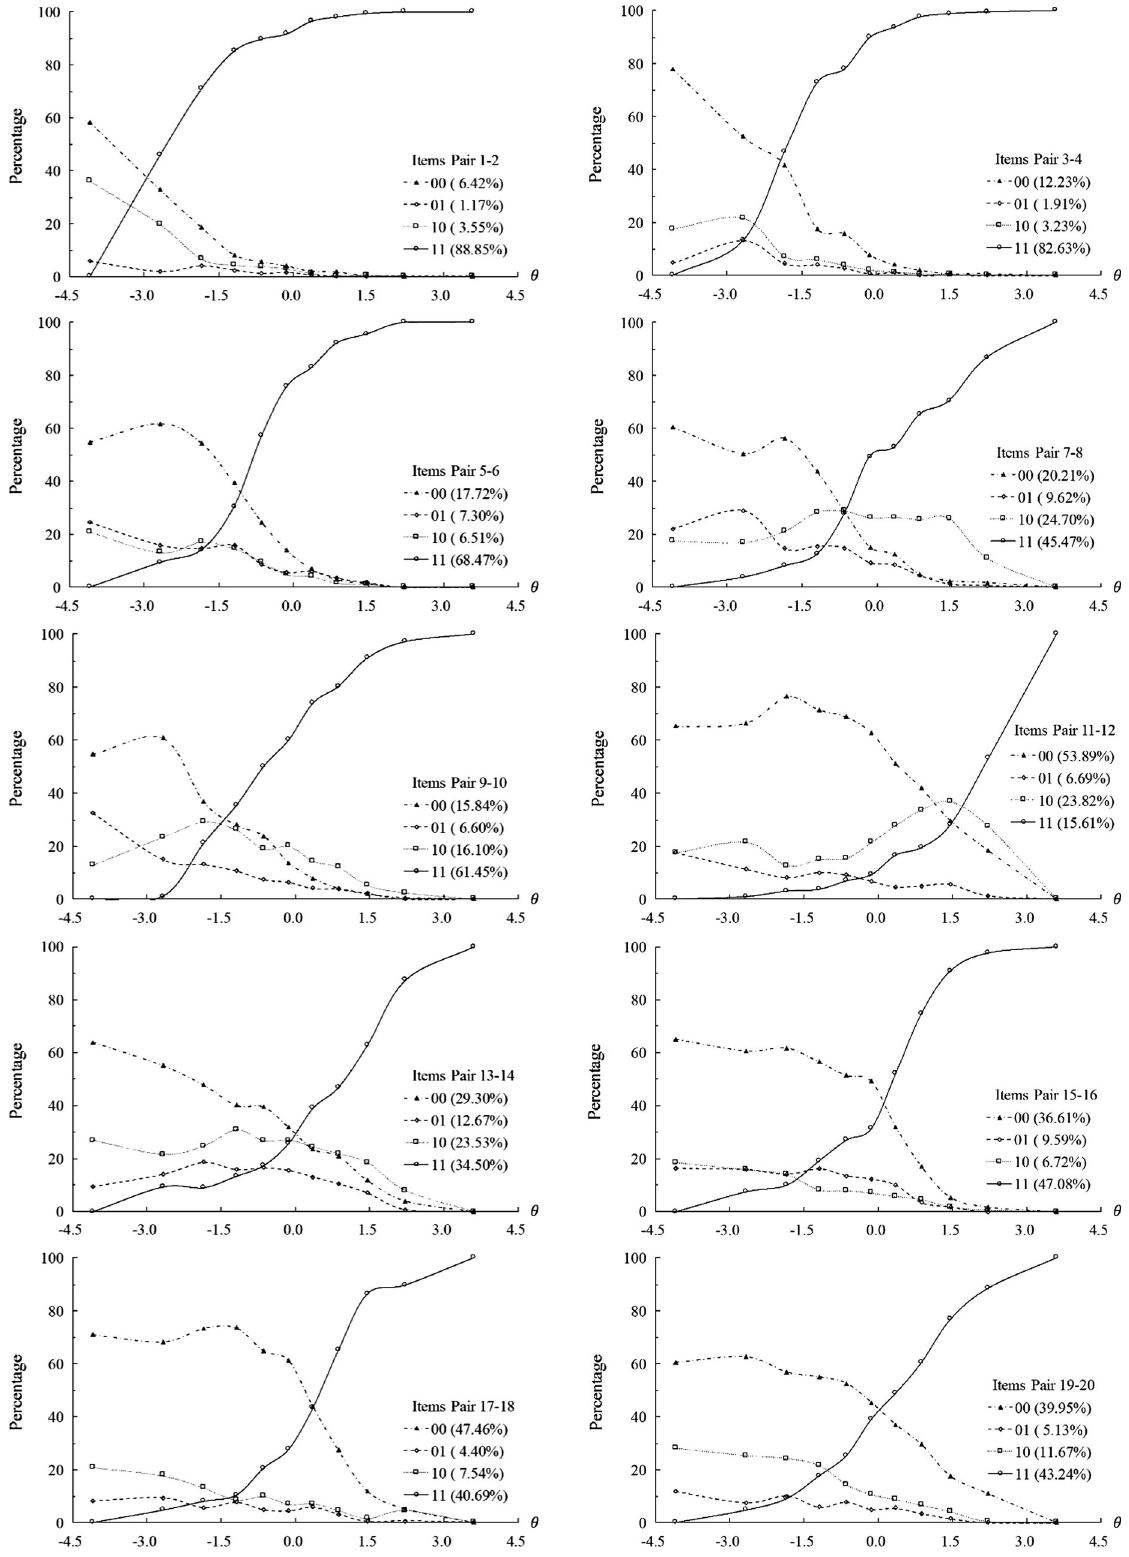
FIG. 3. Item response curves (IRCs) of S2. Student ability was estimated based on